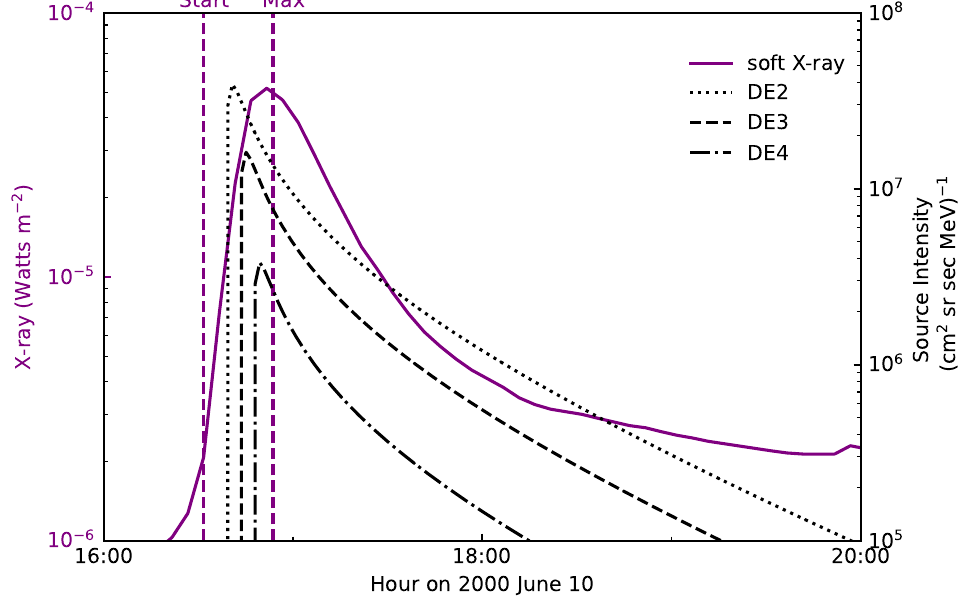
Figure 5. Comparisons of X-ray observed by GOES and the particle source profiles for the 10 June 200 simulation. The purple curve indicates the X-ray intensity for the flare. The dotted, dashed, and dash-dot curves are the intensity profiles of the particle sources used to simulate the DE2–DE4 en- ergy channels, respectively. Vertical lines indicate the moments of the flare onset and maximum.